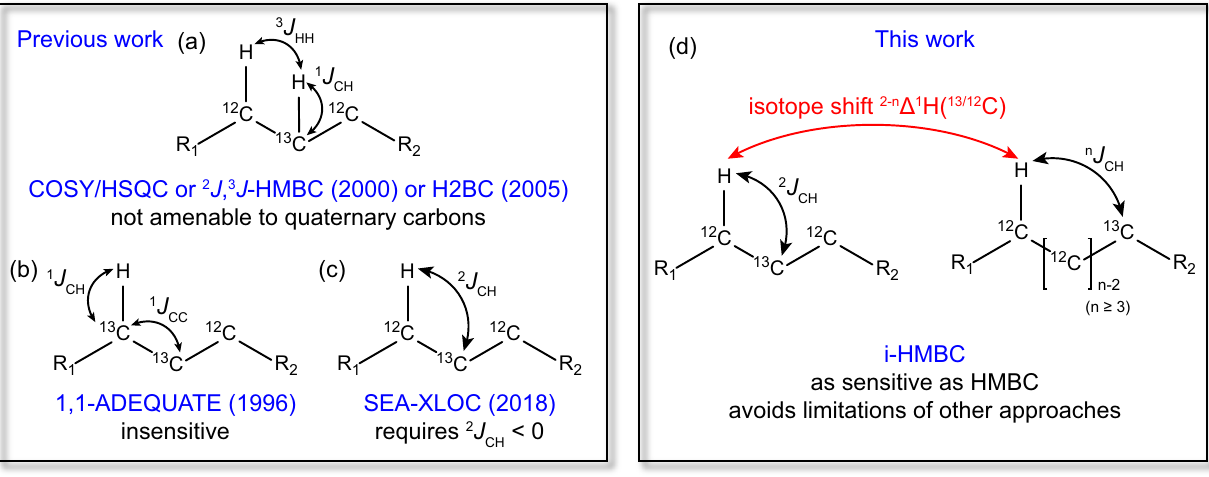
Fig.1|Overviewofmethodscapableofidenti fi cationoftwo-bond 1 H- 13 Ccorrelations.a COSY/ 2 J, 3 J-HMBC/H2BC, b 1,1-ADEQUATE, c SEA-XLOCand d